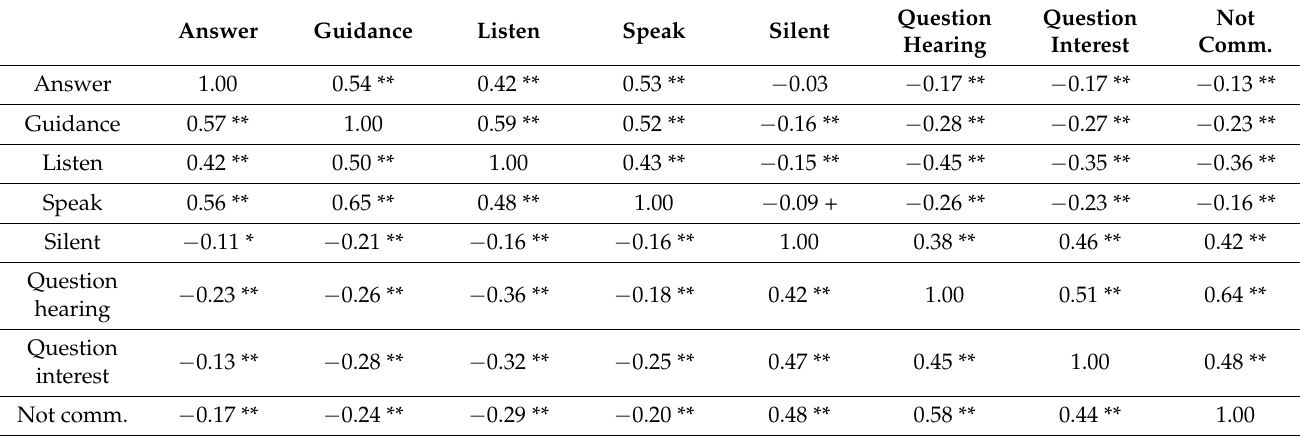
Table 3. Inter-Item Correlations for Divine Engagement/Disengagement: Samples 1 ( N = 400) and 2 ( N =